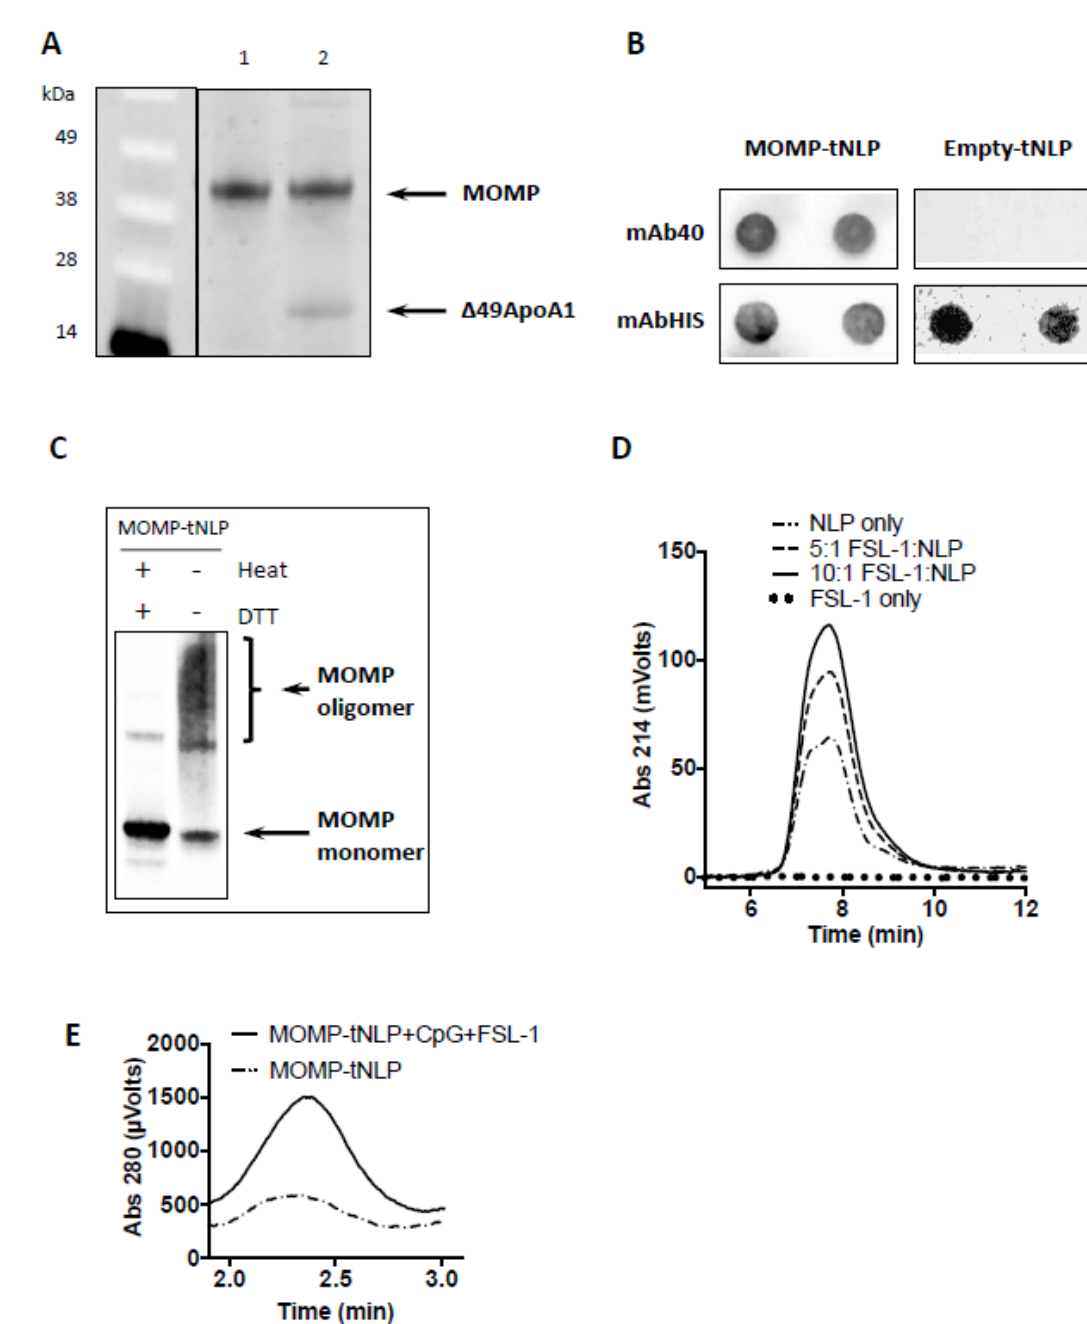
Figure 1. Expression, characterization and adjuvant addition of MOMP-tNLP. ( A ) SDS-PAGE of purified MOMP-tNLP. Left lane (MW markers) Lane 1: One µ g of purified recombinant MOMP. Lane 2: Purified MOMP-tNLP containing one µ g of MOMP. The gel densitometry values are: lane 1 top band, 15,971.3; lane 2 top band 15,887.4; lane 2 bottom band 3629.0 (Ana-lyzed by ImageJ). ( B ) Dot blot of purified MOMP-tNLP and empty tNLP probed with anti-MOMP mAb40, and anti-Histag antibody mAbHIS. Blotting is done in duplicate. Histag is on the N-terminal of tNLP scaffold ∆ 49ApoA1. ( C ) MOMP forms higher order structures in MOMP-tNLPs as analyzed by Western blot. In the right lane, the presence of higher order bands indicates MOMP multimer conformation. In the left lane, heat and denaturant break down higher order MOMP structures (samples were boiled for 5 min in the presence of 50 mM DTT). The gel densitometry values are: left lane top bands, 841.9; left lane bottom band, 9239.1; right lane top bands 6077.9; right lane bottom band 3643.4 (Analyzed by ImageJ). ( D ) FSL-1 adjuvant incorporation into NLPs. FSL-1 is a lipopeptide that can be anchored in the NLP bilayer via the acyl chains. SEC demonstrates dose-dependent incorporation of FSL-1, evidenced by an increase in absorbance at 214 nm. ( E ) SEC traces of MOMP–tNLP particles with and without adjuvant addition. Same amount of MOMP-tNLP were loaded onto SEC. The increase in A280 indicates association of adjuvant CpG with the